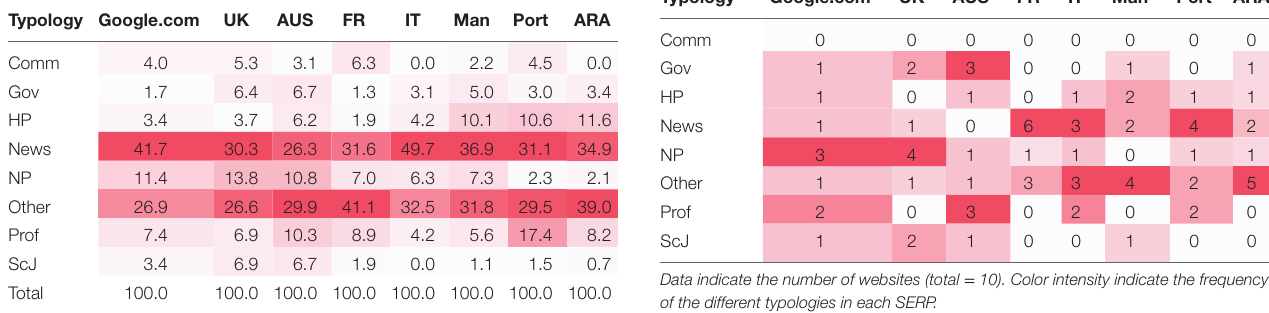
Table 3 | Composition of the search engine result page (SERP) by typology of webpages. Typology google.com UK aUs Fr iT Man Port